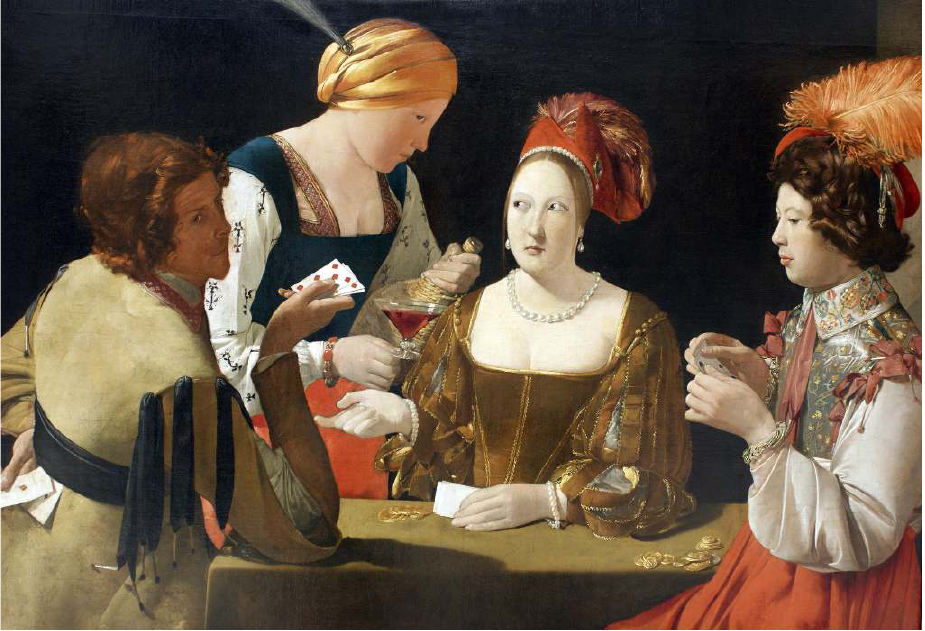
Louvre Museum. Source: https://commons.wikimedia.org/wiki/